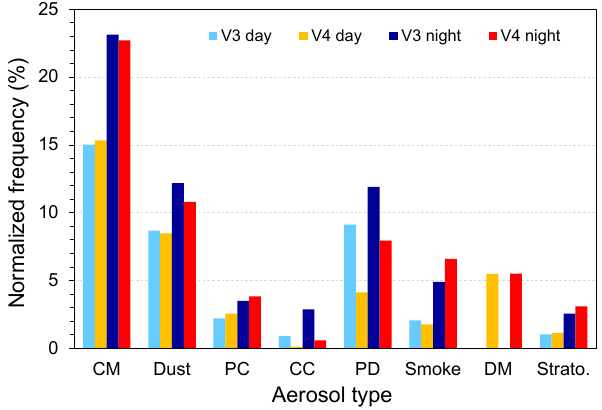
Figure 13. Normalized frequencies of aerosol subtypes in V3 and V4 for daytime and nighttime. Note that “strato.” represents strato- spheric features for V3 but stratospheric aerosols for V4. CM: clean marine; PC: polluted continental; CC: clean continental; PD: pol- luted dust; DM: dusty